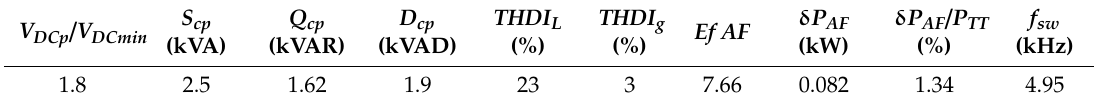
Figure 21. Oscillograms for the adaptive control at nominal load in steady state regime: ( a ) load current and supply current after compensation; ( b ) phase voltage and current after compensation. Table 5. The main experimental energetic performances of the adaptive control, at nominal load. V DCp / V DCmin